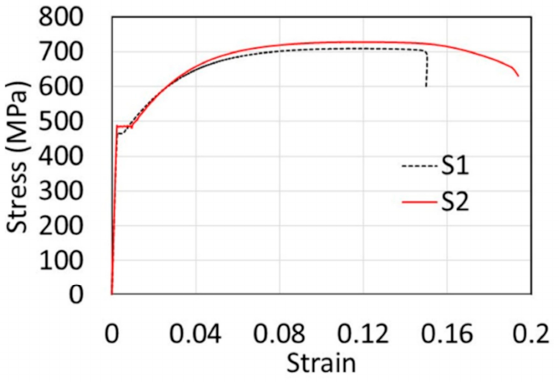
Figure 6. Stress–strain curves for longitudinal reinforcement.